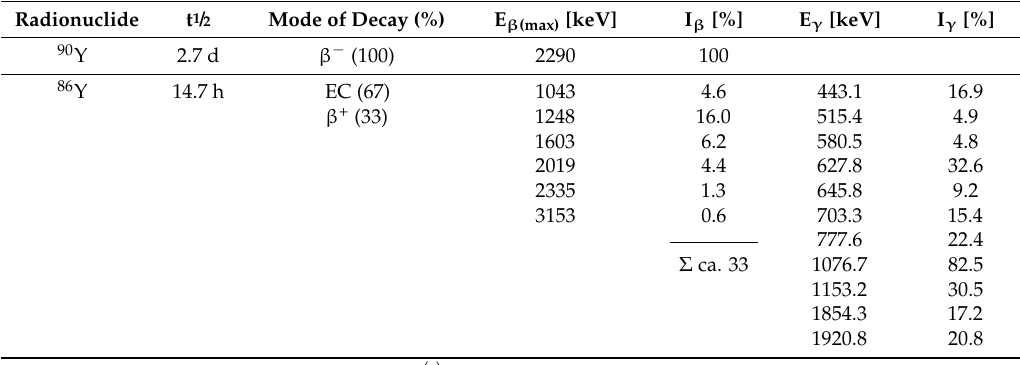
Table 1. Major decay data of the radionuclide pair 86 Y and 90 Y (a) .